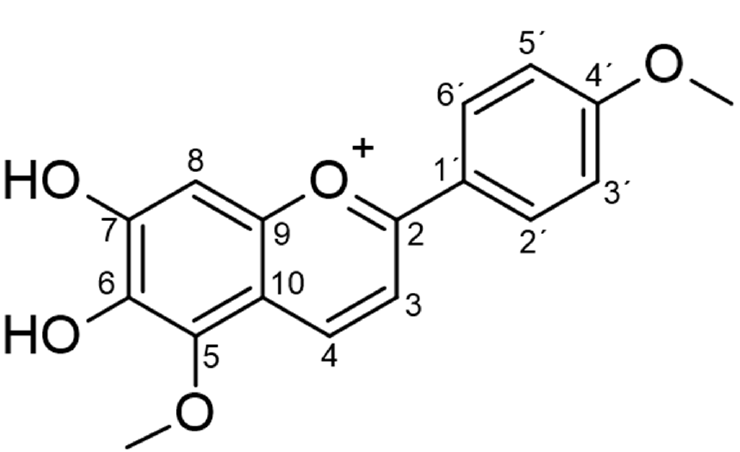
Figure 1. Chemical structure of carajurin.